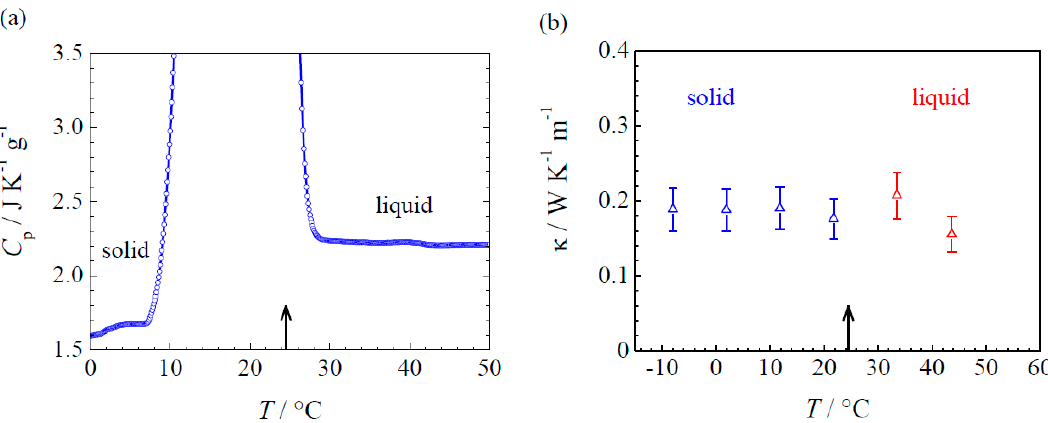
Figure 7. ( a ) Heat capacity at constant pressure as a function of temperature, C p ( T ), of R-CNO measured by DSC. Data points in the region of the solid-liquid transition approach infinity and are omitted. ( b ) Thermal conductivity, κ , of R-CNO as a function of temperature measured by a Physical Property Measurement System (PPMS). The arrows indicate the DSC peak melting temperature, T mpt , of